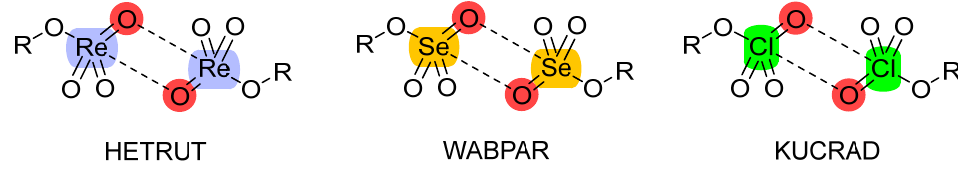
Figure 1. Three structures studied in this work and the CSD [17] reference codes.